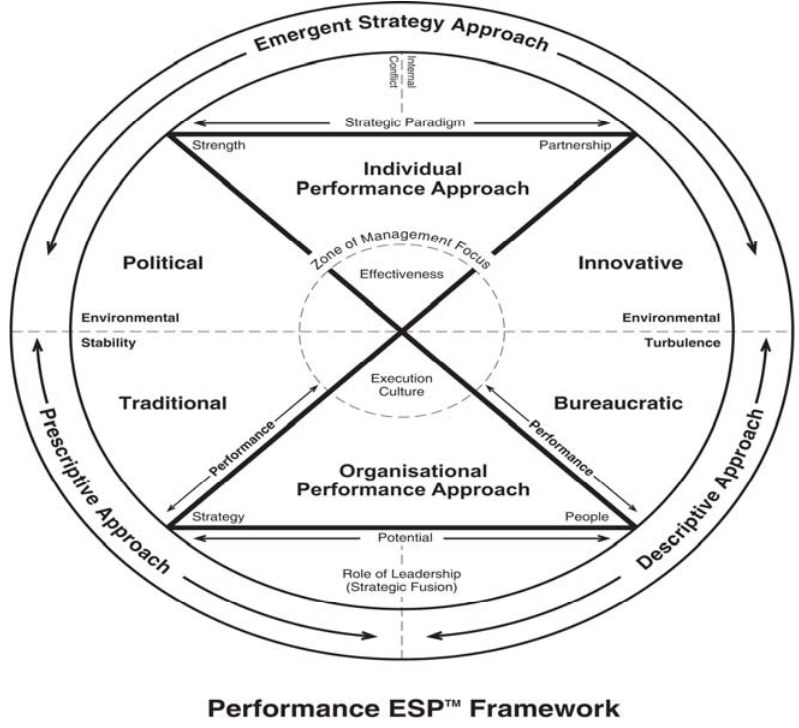
Figure 2: The performance ESP